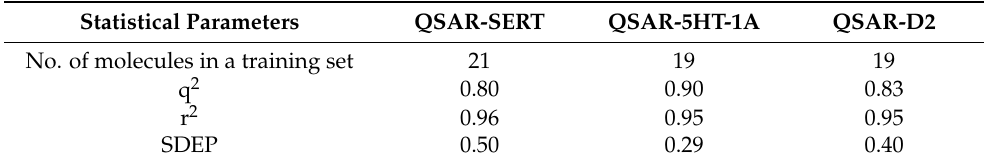
Table 5. Summary of the ALMOND statistical parameters in QSAR-SERT, QSAR-5-HT1A, and